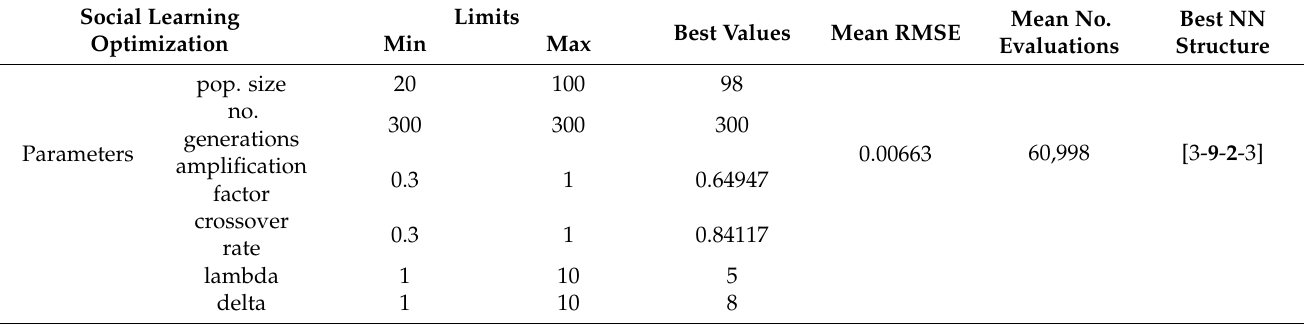
Table A4. ThebestresultsprovidedbythesearchprocedurefortheSocialLearningOptimizationalgorithm.